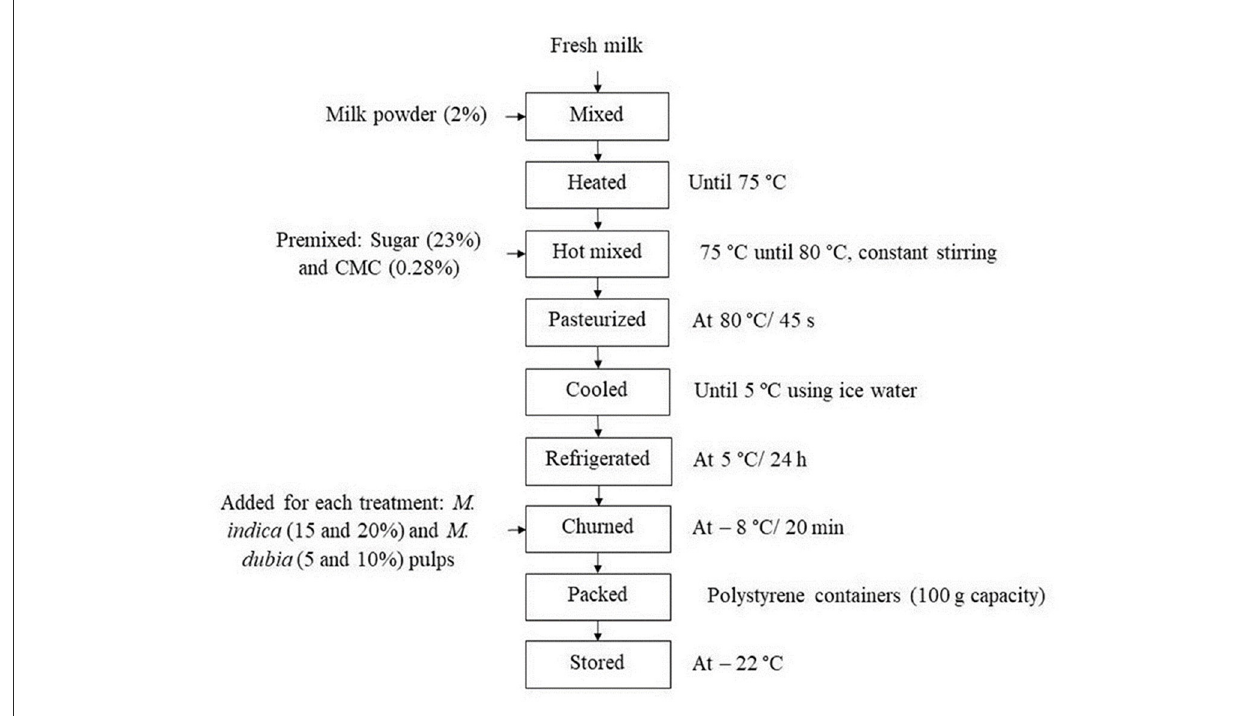
FIGURE1 Flow diagram of the ice cream